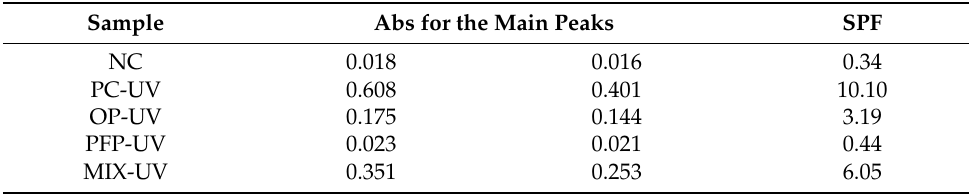
Table 5. SPF values for the formulations and absorbance values for the main peaks. Sample Abs for the Main Peaks SPF NC 0.018 PC-UV